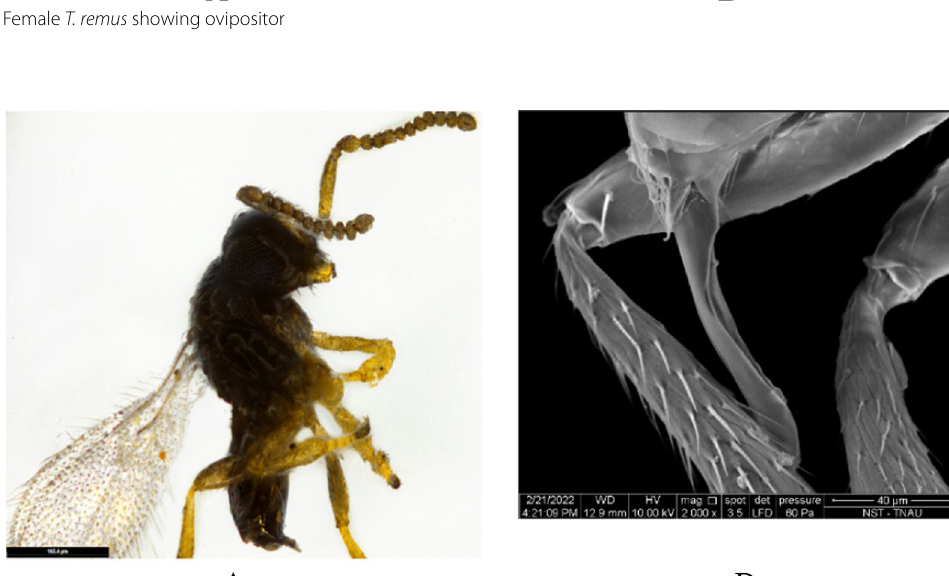
Fig. 15 A, B Male T. remus showing